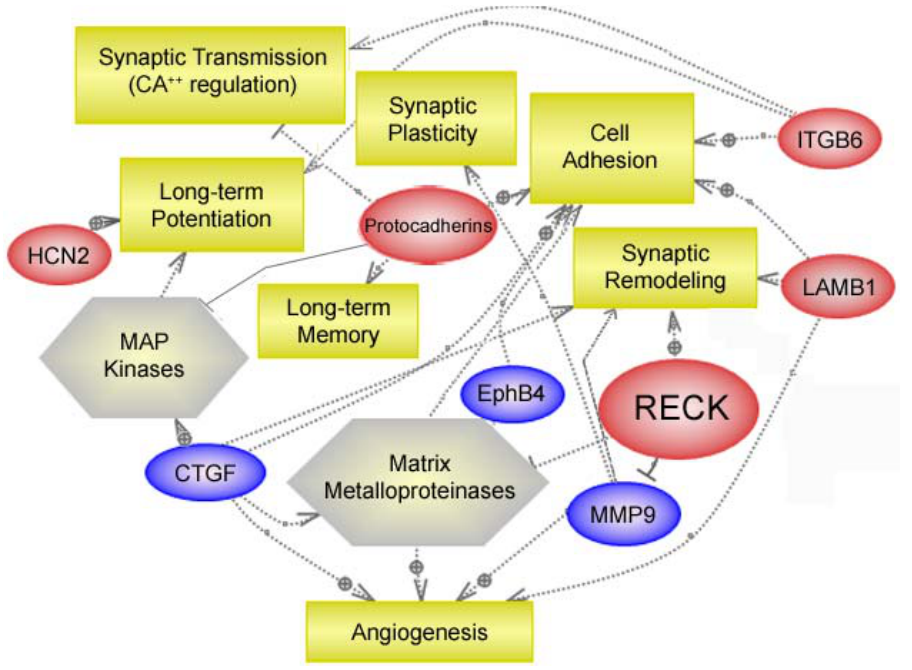
Figure 6. Schematic representation of coordinated gene expression changes and signaling pathways activated in the hippocampus of cocaine abusers compared to age-matched and drug-free control subjects. The biological network was identified by incorporating the gene expression results into Pathway Studio (Ariadne Genomics, Rockville, MD). Oval-shaped symbols represent regulated transcripts, square symbols illustrate cellular or molecular functions and arrows denote some of their possible interactions. Upregulated transcripts are shown in red; purple illustrates downregulated genes. Matrix metalloproteinases (hexagonal symbol, center) are zinc-dependent endopeptidases that degrade numerous extracellular matrix proteins. MAP kinases and other essential kinases play roles in the expression of long-term potentiation. Many of the dysregulated genes associated with cell adhesion and extracellular matrix remodeling are involved in memory and learning processes. Changes in MMP9 activity are a requirement for remodeling of extracellular matrix cell adhesion molecules occurring with synaptic plasticity, which in turn is necessary for memory consolidation. Abbreviations: HCN-2, hyperpolarization activated cyclic nucleotide-gated potassium channel 2; CTGF, Connective Tissue Growth Factor; RECK, Reversion-inducing-cycteine-rich protein with kazal motifs; MMP9, matrix metalloproteinase 9; EphB4, ephrin receptor B4; LAMB1, laminin beta 1; ITGB6, Integrin, beta 6.